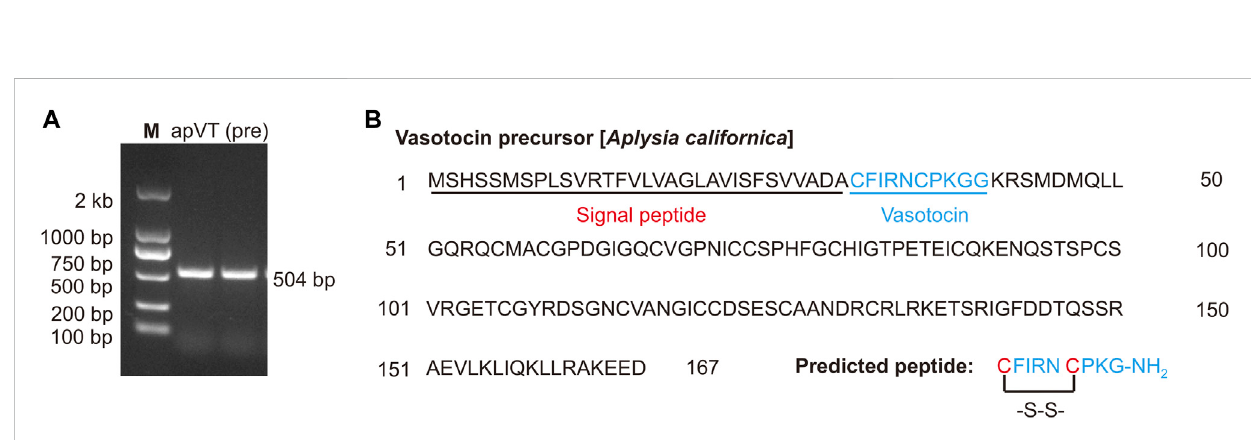
Cloning of the apVT precursor. (A) A PCR product for apVT precursor gene with a length of 504 bp. (B) The complete protein sequence of the apVT precursor gene illustrates the signal peptide and a predicted peptide in blue: vasotocin. The predicted mature peptide undergoes two post-translational modi fi cations: the last Gly at the C-terminus is typically amidated and the two cysteines (shown in red) form a disul fi de bond.